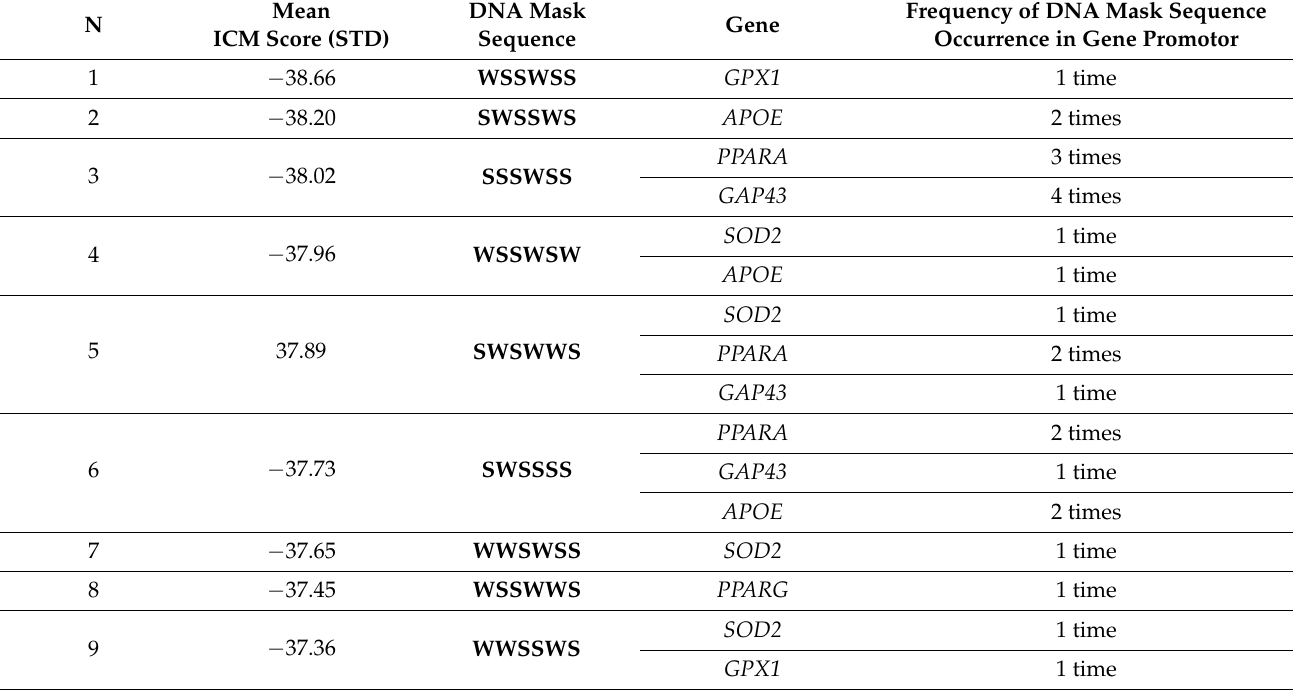
Table 2. Occurrence of low-energy DNA mask sequences in promotors of the genes involved in